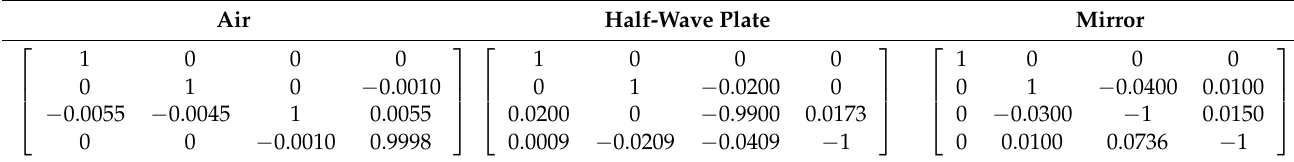
Table 2. Measured Mueller matrices of standard optical samples.